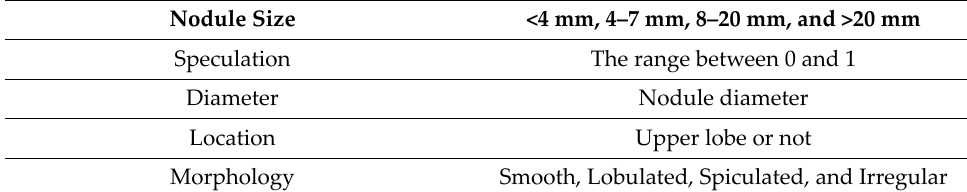
Table 3. High‑level (semantic) features for lung nodule